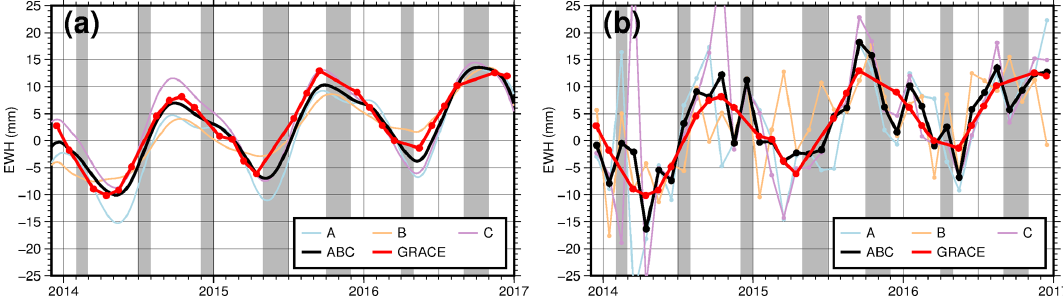
Figure 9. Influence of individual satellites on the combined solution. (a) CTAS solutions. (b) Monthly